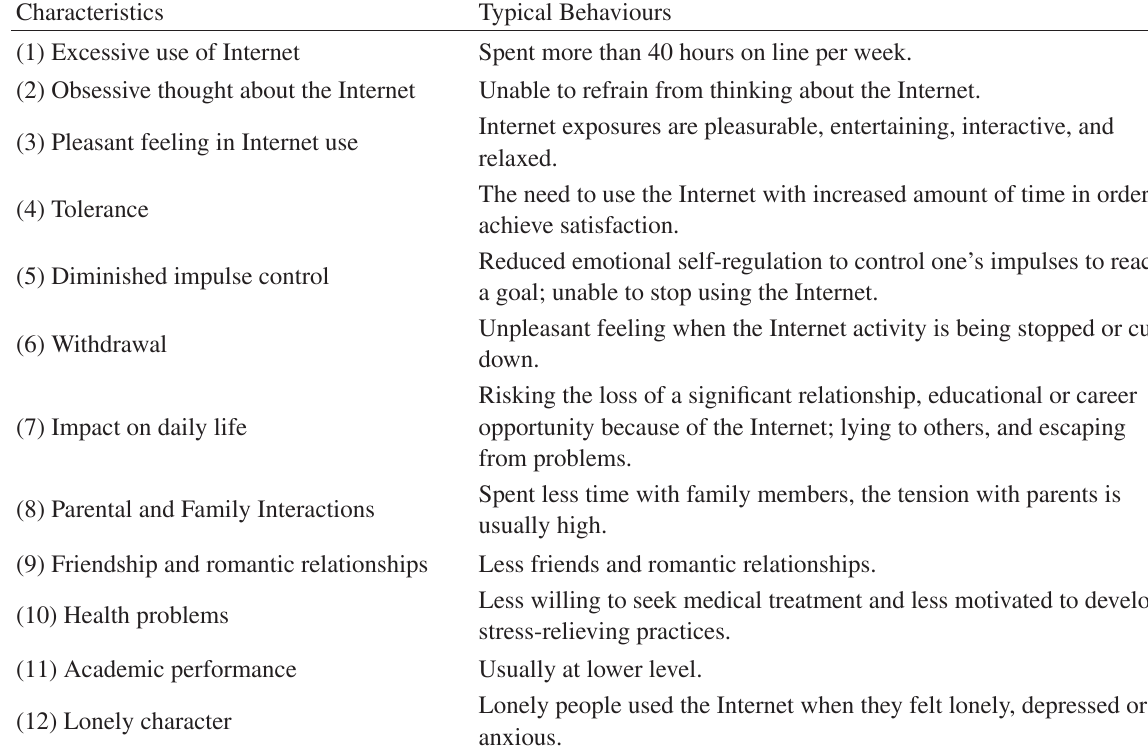
TABLE 1: Characteristics of Internet